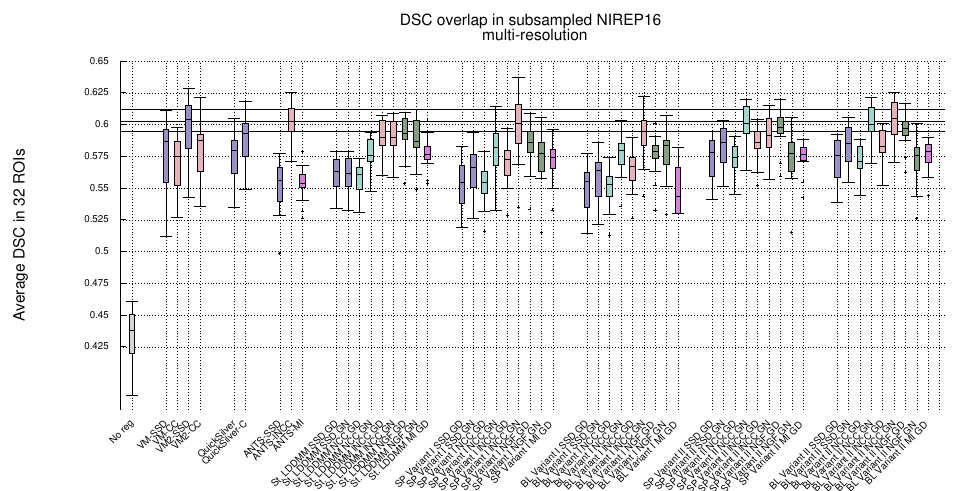
Figure 1. NIREP16. Volume overlap obtained by the registration methods measured in terms of the DSC between the warped and the corresponding manual target segmentations. Box and whisker plots show the distribution of the DSC values averaged over the 32 NIREP manual segmentations. The whiskers indicate the minimum and maximum of the DSC values. The upper plot shows the evaluation results in the single-resolution experiments. The lower plot shows the results in the multi-resolution experiments. The horizontal lines in the plot indicate the first, second, and third quartiles of one of the best-performing baseline methods (multiresolution ANTS-lNCC), facilitating the comparison.